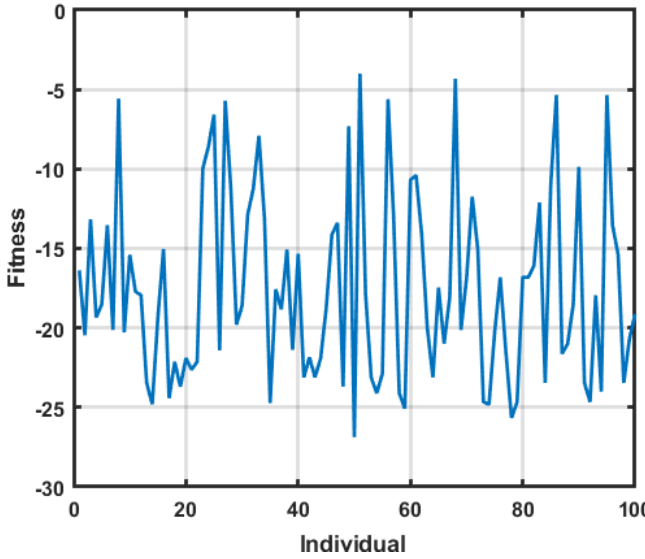
Figure 12. Fitness in the last best population, fitness defined as Equation (31). Table 2. Optimal parameters obtained by looking for in different parameter bounds. Fitness as Equation (29). Bounds GA-Thickness, Spacing, Wire Ø (m)